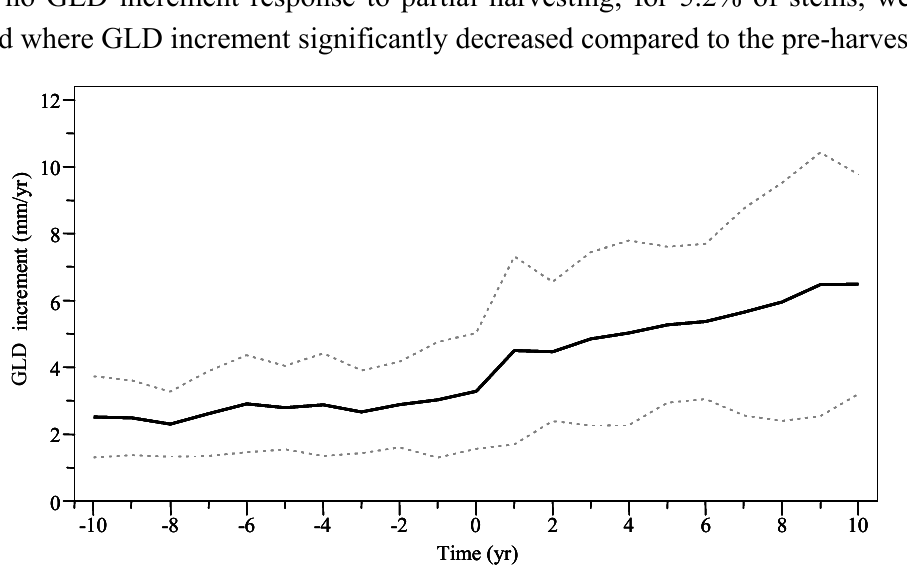
Figure 6. Mean annual GLD increment for ste ms ≥3 years at time of harvest (year 0) of the Outaouais Region (OR site) and Papineau-Labelle wildlife reserve (PL site) ( n = 58 stems). Dashed lines indicate standard error (SE).